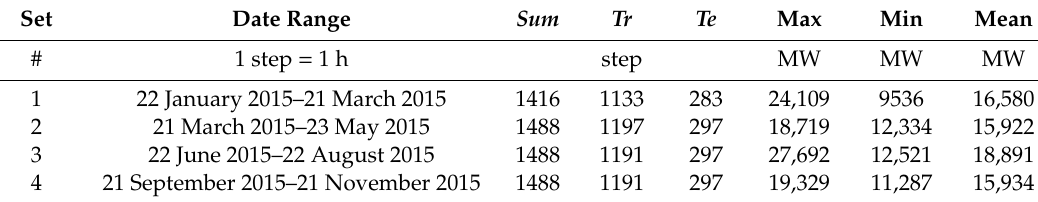
Table 3. Specific information of four datasets.